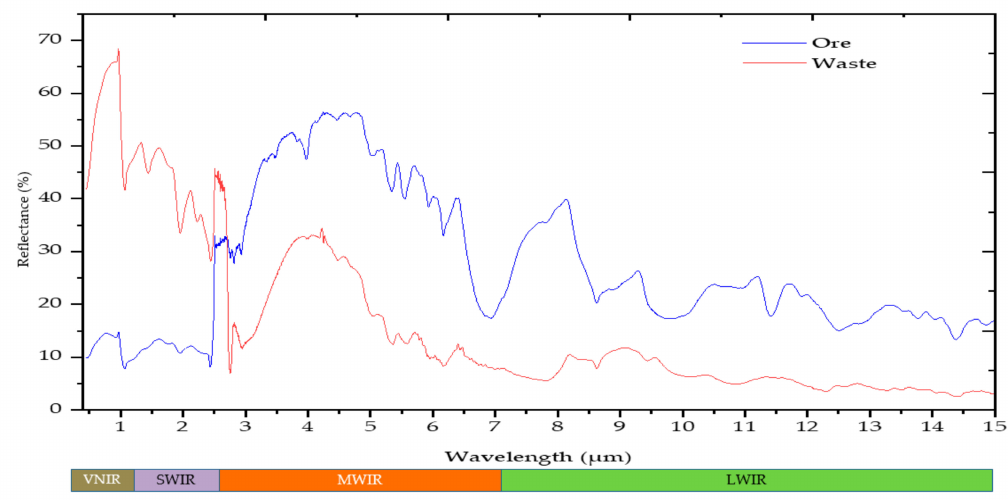
Figure 8. Representative spectra of the ore and waste materials across the VNIR, SWIR, MWIR and LWIR regions of the electromagnetic spectrum. The concentrations of the combined Pb-Zn in these ore and waste samples are 17.5 wt.% and 0.59 wt.%,